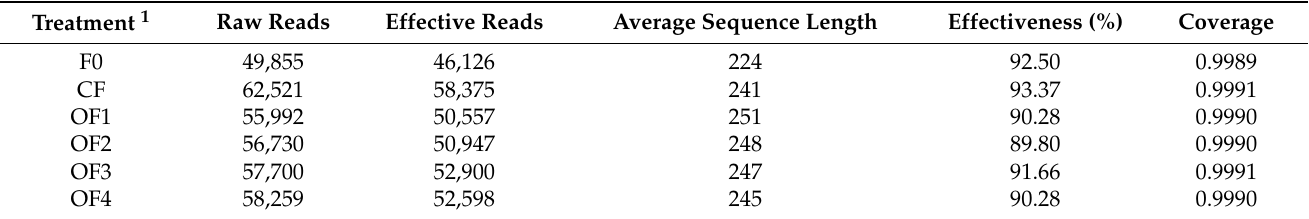
Table 2. Sequencing throughput data for soil fungi according to fertilization